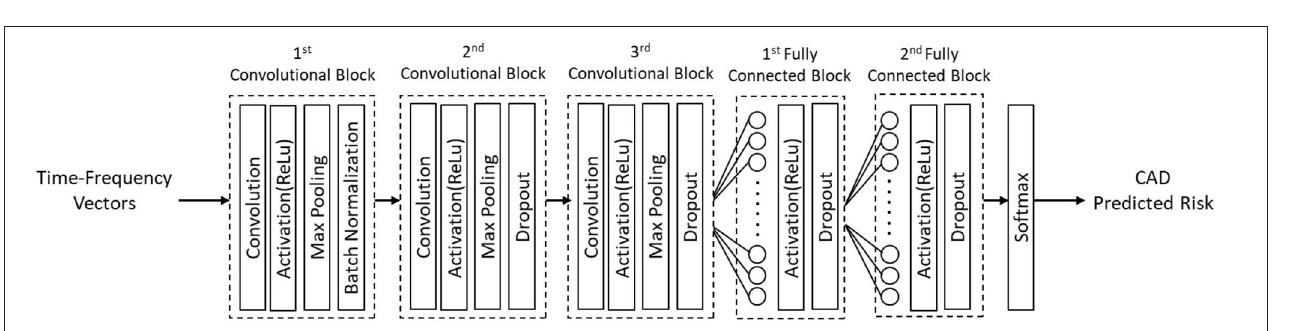
FIGURE 3 | 1D CNN architecture proposed for training the